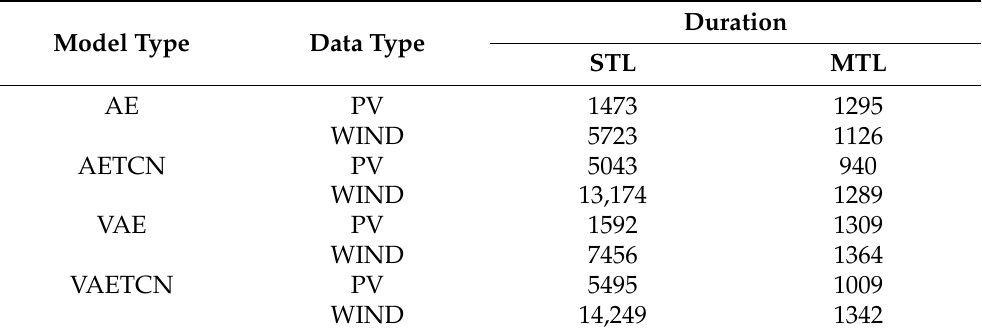
Table 4. Duration to train the different autoencoders in minutes. For the STL models, we trained with five parallel jobs. Each job utilized 20 CPUs and trained a single park. An MTL trained all parks simultaneously through a single job with 50